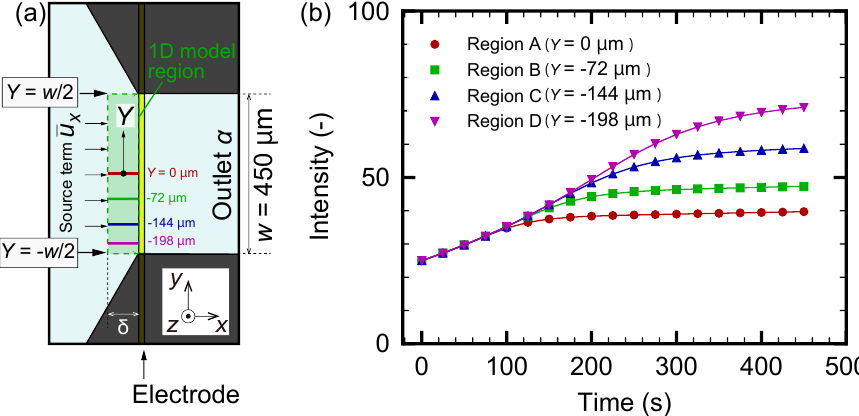
Figure 9. ( a ) Schematic of the numerical model on the concentration increase at the branch. ( b ) Numerical results regarding the time-development for fluorescence intensity of nanoparticles in the regions A ( Y ≈ 0 µ m), B ( Y ≈ − 72 µ m), C ( Y ≈ − 144 µ m), and D ( Y ≈ − 198 µ m), shown in panel ( a ) and corresponding to Figure 6, where Y = 0 µ m is placed at the center of the outlet α in the Y